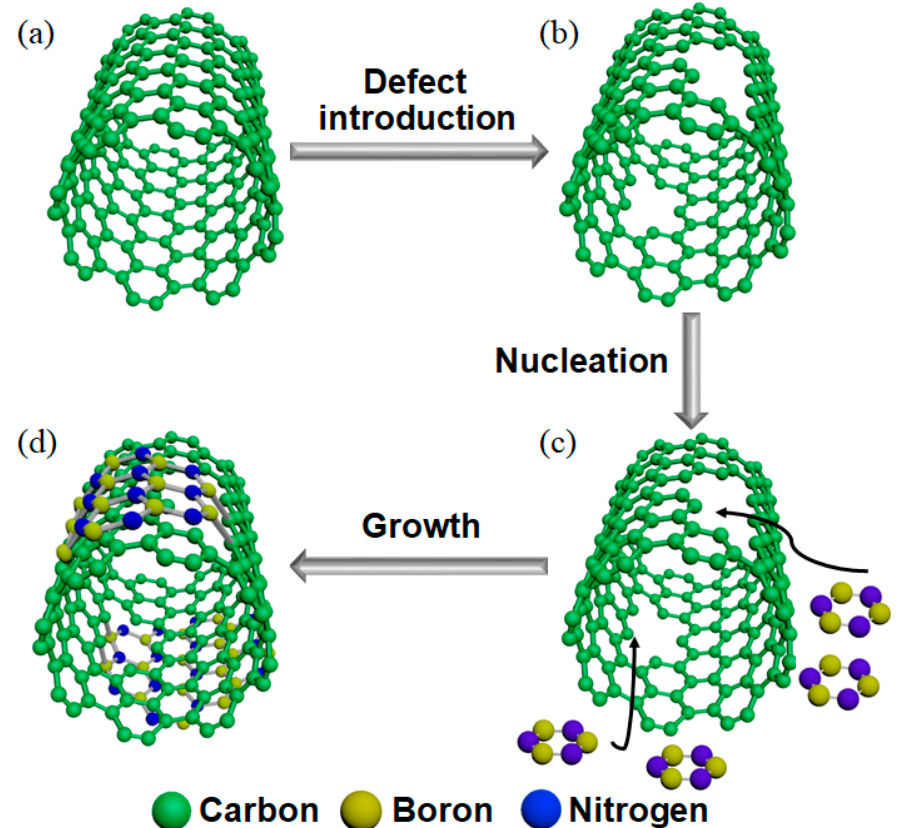
Figure 3. Schematic illustration of the defect-induced heteroepitaxial growth mechanism of SWCNT@h-BN.( a ) Perfect SWCNT. ( b ) SWCNT with defects. ( c ) Atomic B and N adsorbed on the defects of SWCNT. (d) SWCNT coated by h-BN.